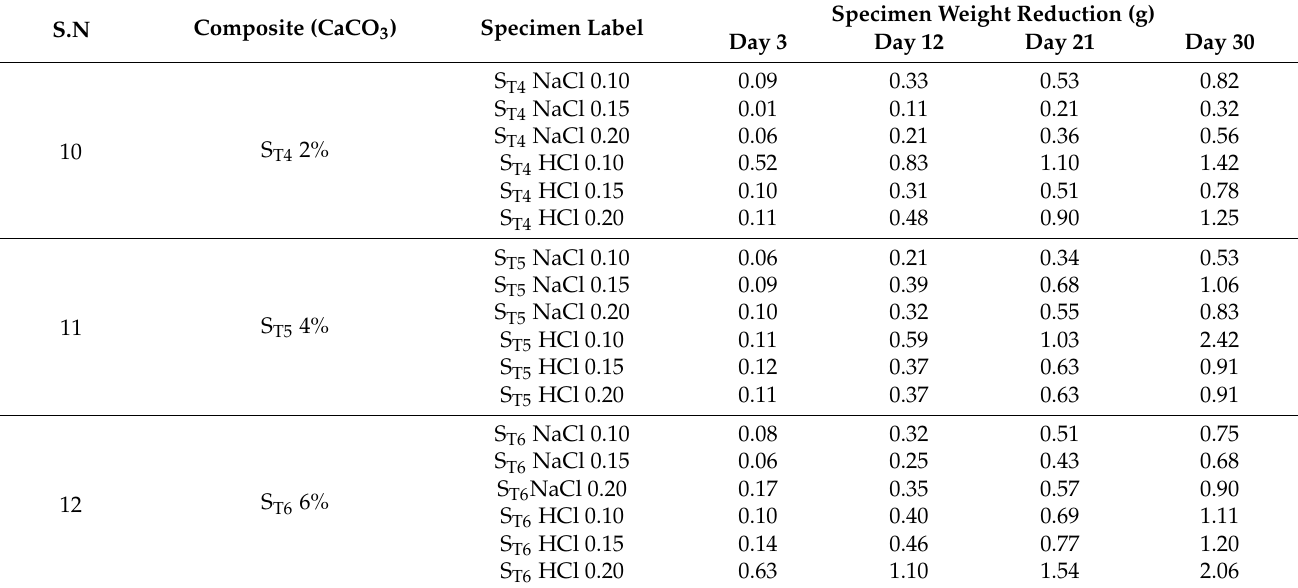
Table 10. Specimen S T4, S T5 and S T6 weight reduction in HCl and NaCl.